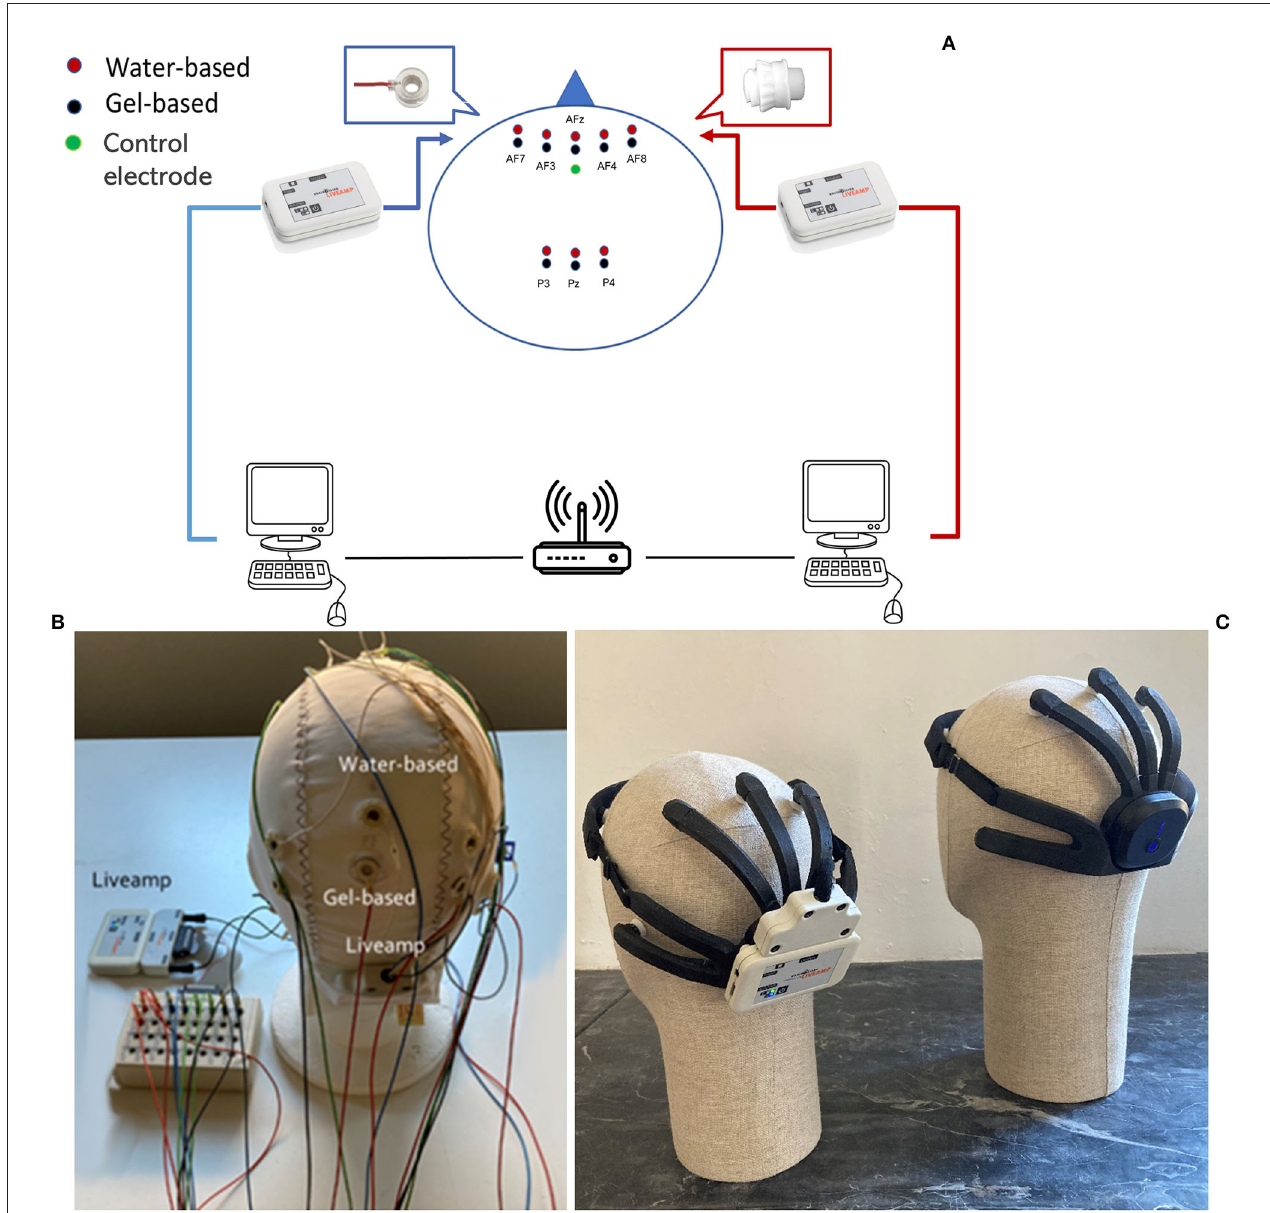
FIGURE 1 | Scheme of the experimental set-up. (A) A scheme of the position of the electrodes and instrumental set-up. Water-based electrodes are shown in red, gel-based electrodes in blue, and the control electrode in green. (B) The actual experimental set-up was used for the EEG sensors comparison. (C) Mindtooth Touch EEG headset, designed for working with water-based electrodes (right), and modified version equipped with the LiveAmp amplifier (left).